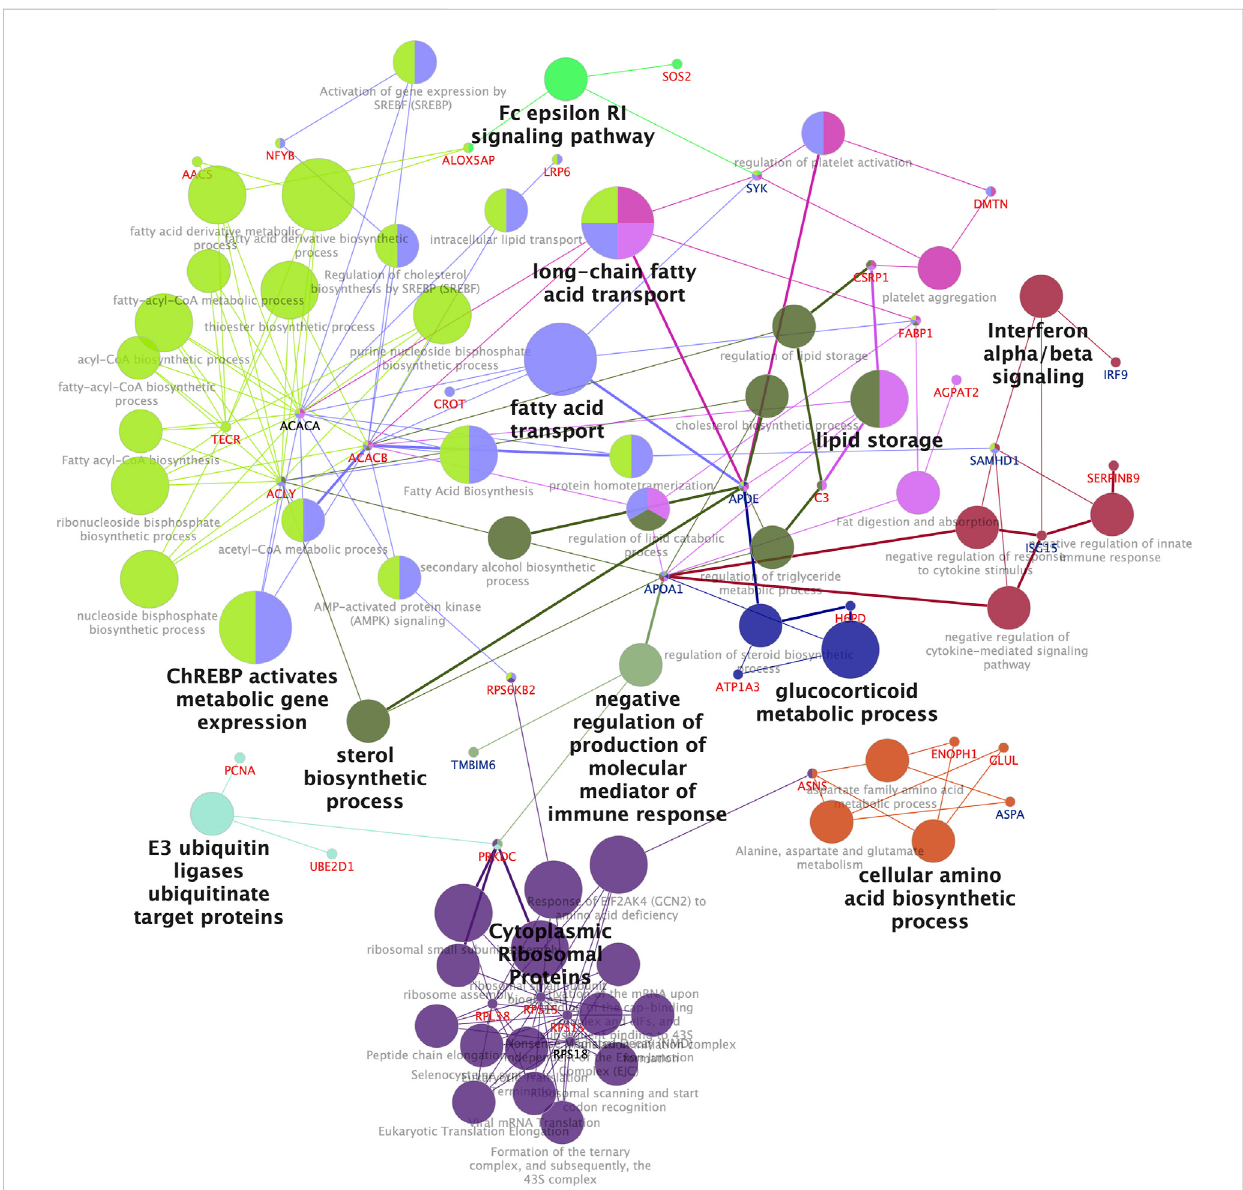
Enriched pathways and networks in proteins differentially expressed in the liver of Atlantic cod injected with WY-14,643. Enrichment of KEGG pathways, Wikipathway, Reactome and Gene Ontology Biological Processes was performed in Cytoscape using the ClueGo application. Functionally related pathway terms (nodes) are grouped by same color, and the label of the most signi fi cant term is highlighted. The node size is proportional to the numberofconstituentproteins.Onlysigni fi cantlyenrichednetworks(Bonferronistep-downcorrection,adjusted p -value < 0.05)areshown.Protein symbols are colored red and blue for up- and downregulated proteins,